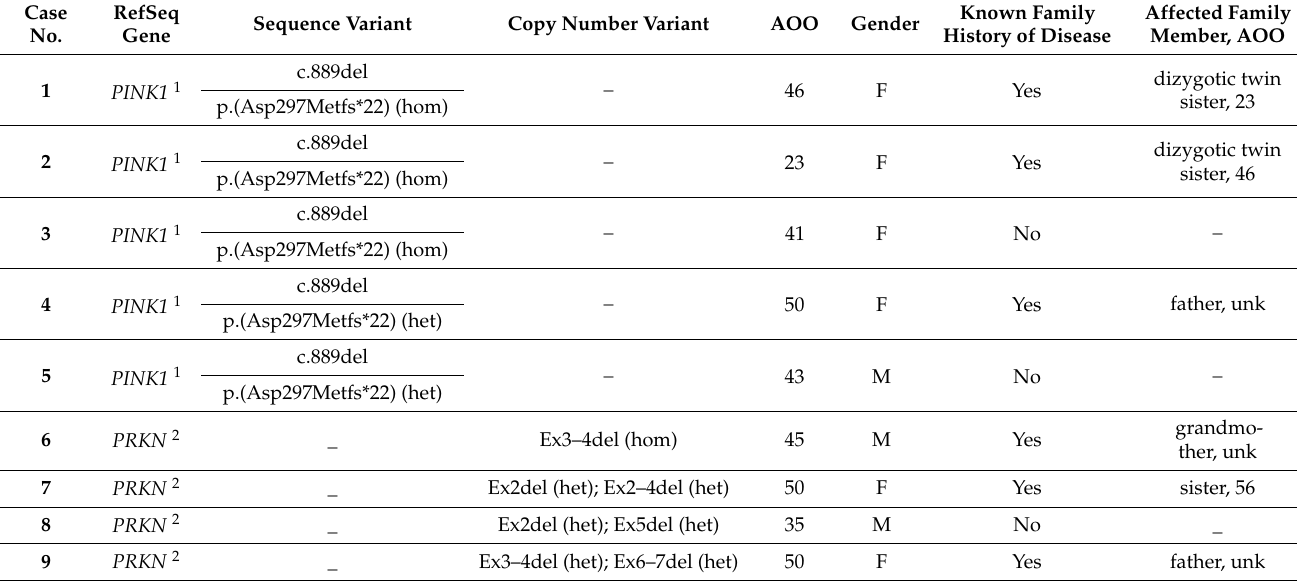
Table 1. Pathogenic variants identified in this